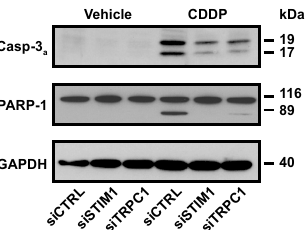
Figure 3. Influence of STIM1 and TRPC1 depletion on CDDP-induced apoptosis. Immunoblot analysis showing the effect of 24 h treatment with 25 µM CDDP on caspase-3 activation and PARP-1 cleavage in siCTRL, siSTIM1 or siTRPC1 transfected cells. GAPDH is used as a loading control. One result representative of at least three independent experiments.